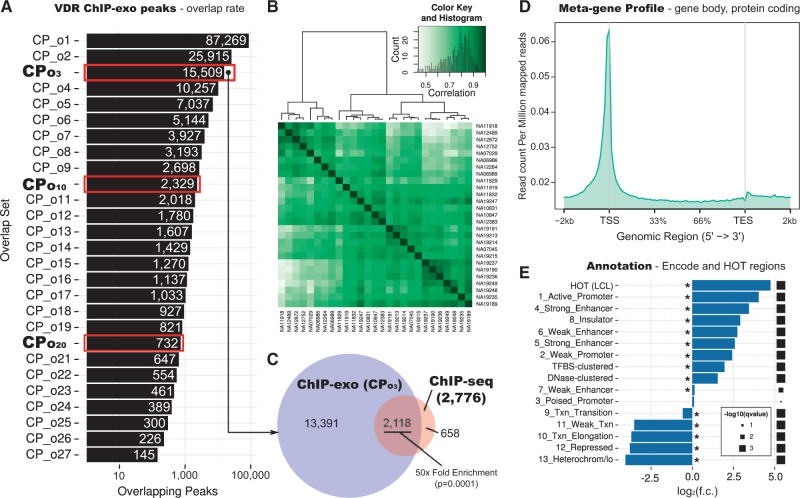
ChIP-exo peaks are reproducible among samples and with previous ChIP-seq results, and are enriched in promoters and enhancers.(A) Numbers of overlapping ChIP-exo peaks across 27 LCL samples (log scale). Highlighted rows indicate numbers of peaks called in at least three (CPo3), ten (CPo10) or twenty (CPo20) samples. (B) Normalised peak read depths (63,62,78) (Supplementary Material) are concordant between samples. VDR ChIP-exo peak binding affinity heatmap, showing pair-wise binding affinity correlation among all 27 sample pairs. (Inset) histogram of correlation counts. (C) 50-fold enriched overlap between CPo3 peaks and the consensus ChIP-seq peakset from (14) (enrichment test: GAT (64), Supplementary Material). (D) Meta-gene profile of VDR binding reads. The panel shows a meta-profile of read pile-up for the pooled 27 LCL samples, averaged over gene bodies (Ensembl v. 75, protein coding genes). (E) Enrichment of VDR binding sites in the CPo3 consensus with ENCODE chromatin states (chromHMM (79)) from LCL NA12878, TF-dense regions (HOT (17) and ENCODE clustered TF binding sites) and DNase I hypersensitive areas (ENCODE). Asterisk denotes significance at 1% False Discovery Rate (FDR) threshold (enrichment test: GAT (64), Supplementary Material).